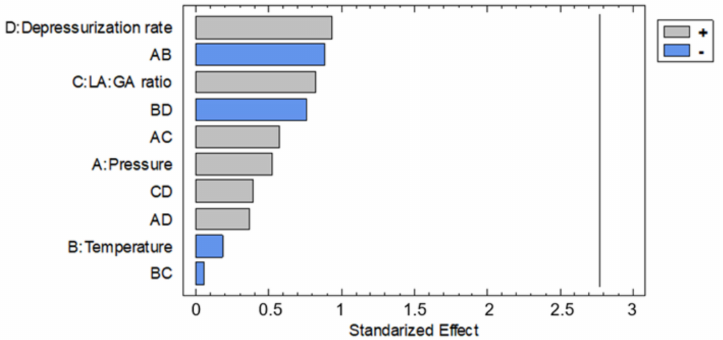
Figure 3. Effect of the considered variables on the expansion factor of the foamed polymer samples.